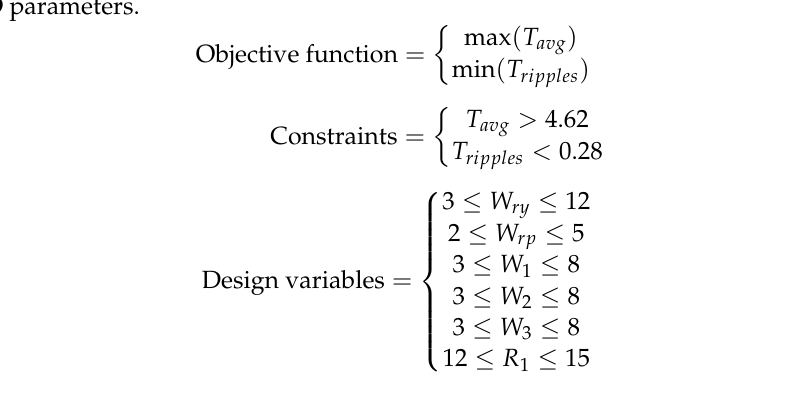
Table 3. Variables for Genetic Optimization.